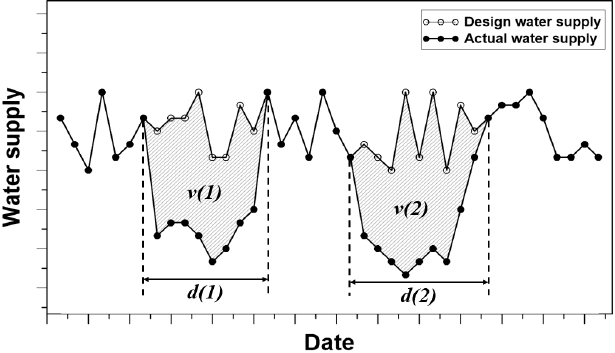
Figure 1. Definition of water deficit volume ( v ( i )) and duration ( d ( i )) (the water deficit intensity is calculated by dividing the deficit volume by the deficit duration) .